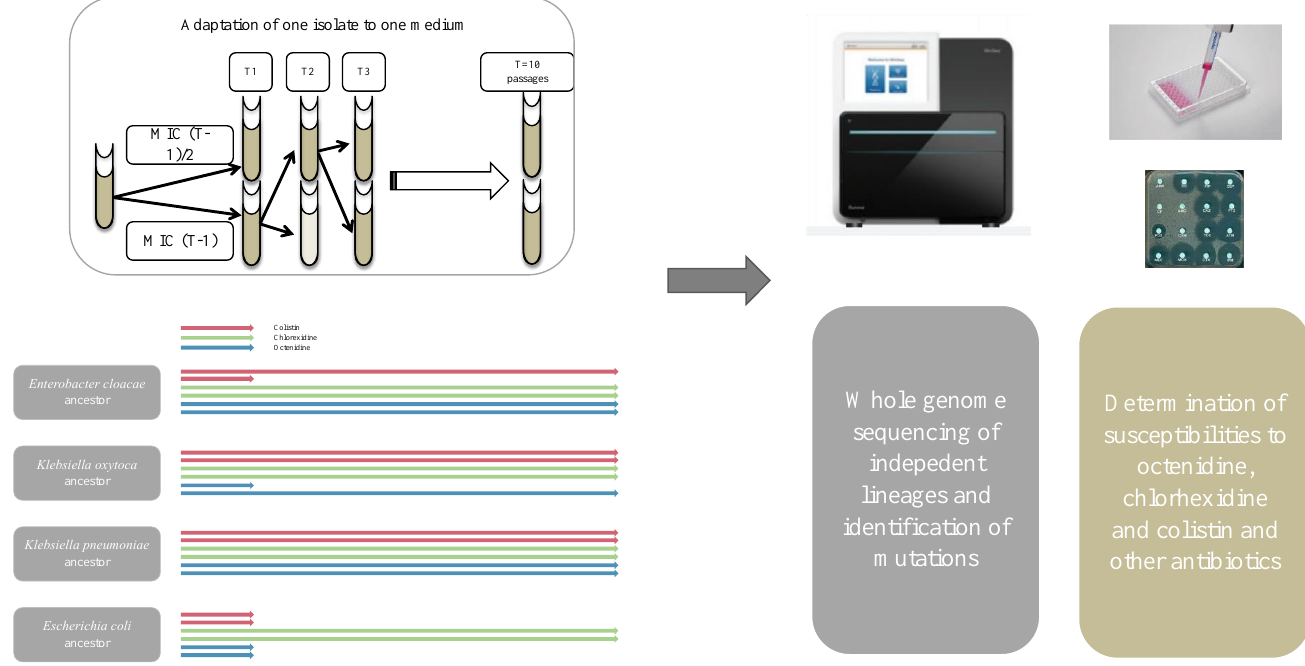
Figure 1. Description of the method used in the present study to obtain mutation and susceptibility data of the different lineages obtained after adaptation of 4 enterobacterial species in 3 selective media (OCT, CHX or COL). The arrows show how a selective process was conducted overtime, with some lineages ending up prematurely due to lack of selection of resistant mutants, and other lineages reaching elevated concentrations.